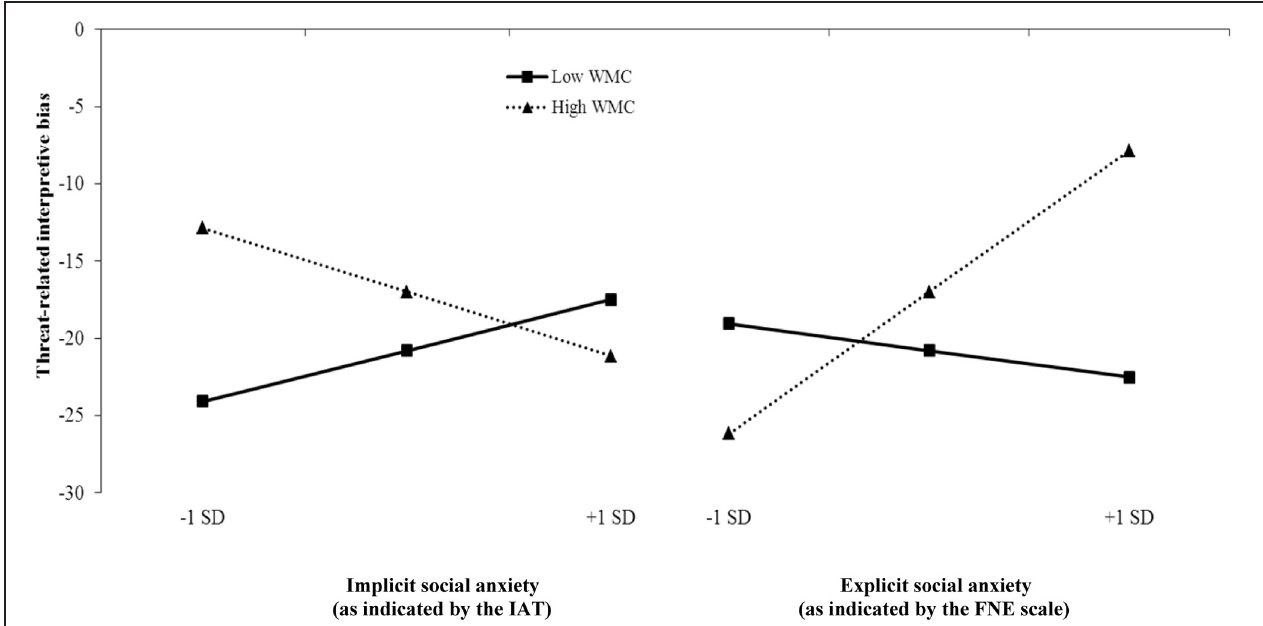
high ( + 1 SD) implicit social anxiety, as indicated by the IAT, (left panel) or individuals with low ( − 1 SD) and high ( + 1 SD) fear of negative evaluation as an indicator of explicit social anxiety (right panel) depending on low ( − 1 SD) and high ( + 1 SD) working memory